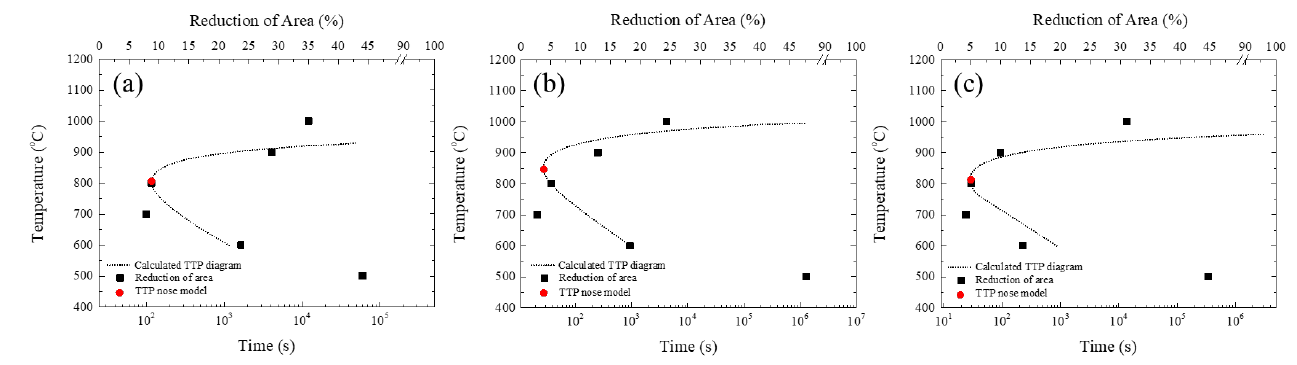
Figure 10. The comparison of prediction model results and reduction of area curves; ( a ) Steel A, ( b ) Steel B, ( c ) Steel C; (dashed line: calculated TTP diagram from J-matpro, square point: reduction of area and red dot: TTP nose from prediction model).